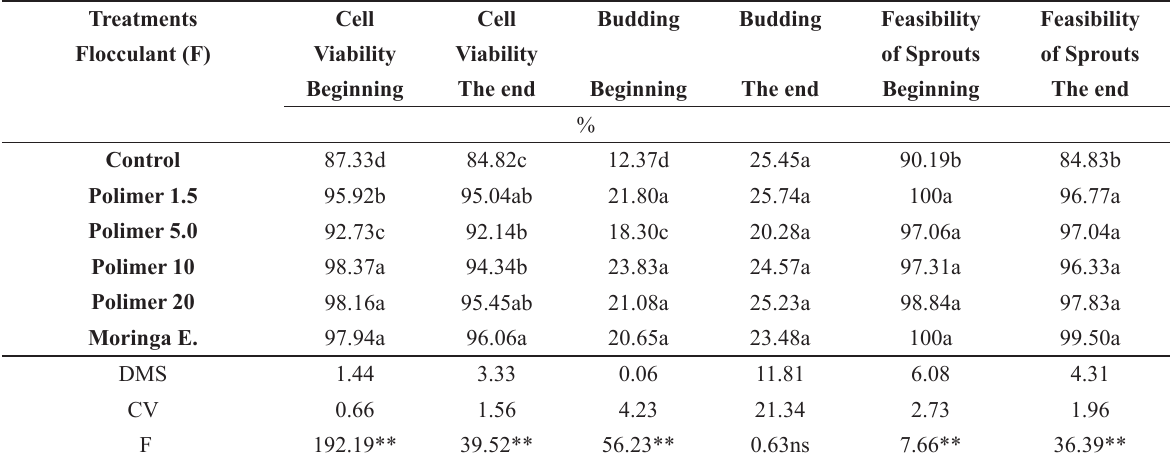
Results obtained for Cell Viability, Budding and Feasibility of Sprouts at the beginning and at the end of the fermentative process of musts obtained from clarified juice with 5 sedimentation aids. Jaboticabal-SP. 2015/2016 crop year. Treatments